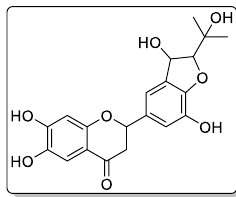
Figure 8. This is chemical formula of the compound 2 (Figure 3). Compound 3 — 2-(3,4-dimethoxyphenyl)-5,7-dimethoxychroman-4-one (Figure 9), 175 mg of the compound was isolated: the yield was 1.5 % and the structure identified by NMR spectrometry (Figure 4).